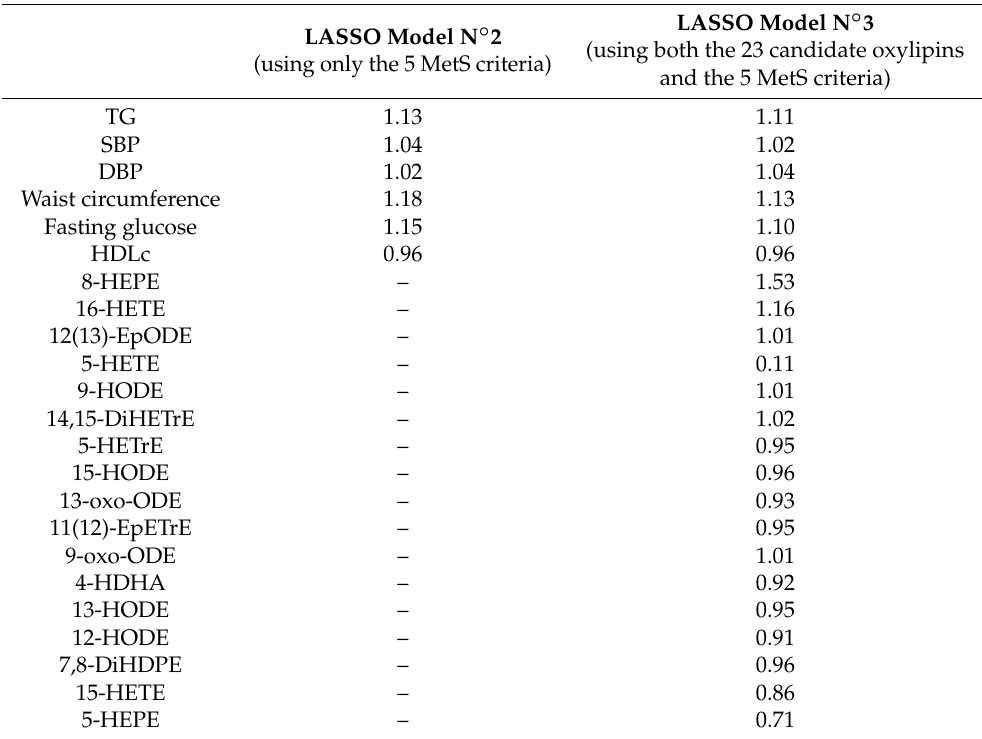
Table 2. Odd ratios (OR) associated with the variable selected in the LASSO models constructed from the candidate oxylipins and/or the MetS criteria. Two new LASSO models were constructed with the participants in the Discovery study using either only the 5 criteria of MetS (i.e., waist circumference, blood pressure, fasting glucose, triglycerides and HDLc, LASSO model N ◦ 2, ”–” for not applicable for this model) or the 5 criteria of MetS and the 23 candidate oxylipins (column 3, LASSO model N ◦ 3). Of note, the 5 MetS criteria were the criteria of selection of MetS participants. The predictive performance of these two LASSO models reached a cross-validated AUC of 93% (95% CI: 90–96%) and 95% (95% CI: 90–96%), respectively. Six candidate oxylipins (i.e., 9(10)-Ep-stearic acid, 12-HETrE, 7-HDHA, 9,10-DiHOME, 9,10-DiHODE and 9(10)-EpOME) out of the 23 provided were not selected in the LASSO model N ◦ 3.